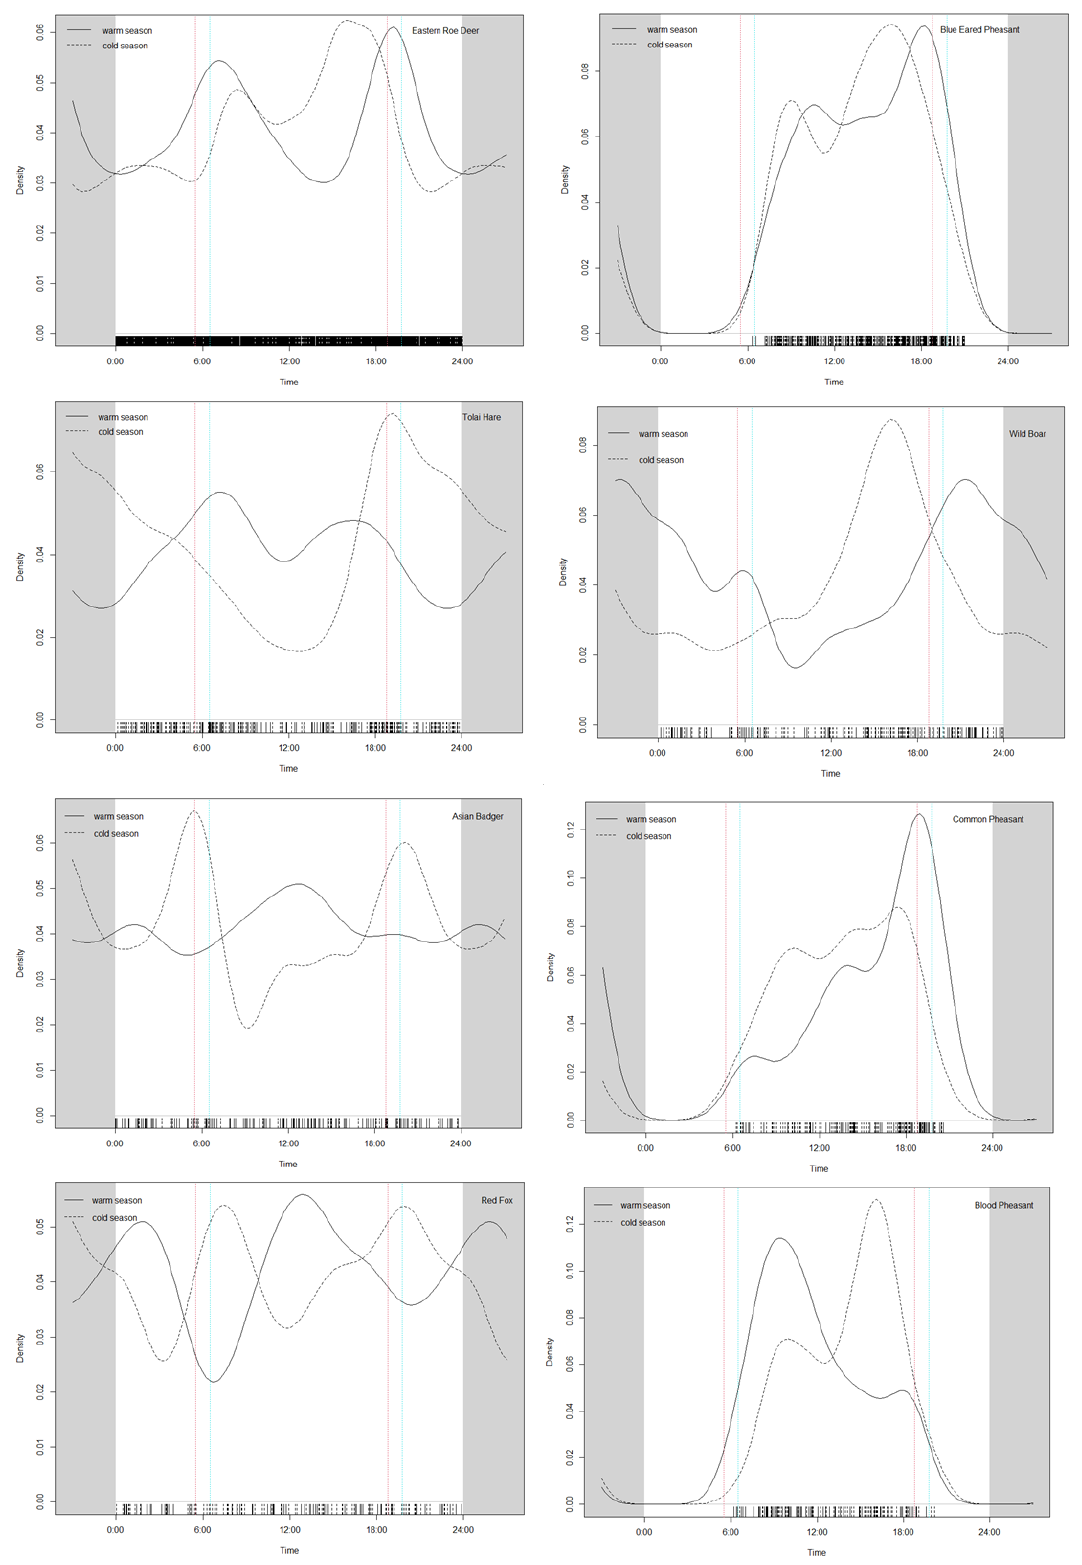
Figure 3. Black dotted and solid lines represent the seasonal (warm season and cold season) activity patterns of the eight dominant species, the red line indicates the time of sunrise ( left ) and sunset ( right ) in the warm season, and the blue line indicates the time of sunrise ( left ) and sunset ( right ) in the cold season, on the eastern Qinghai-Tibet Plateau (2017 – 2020).